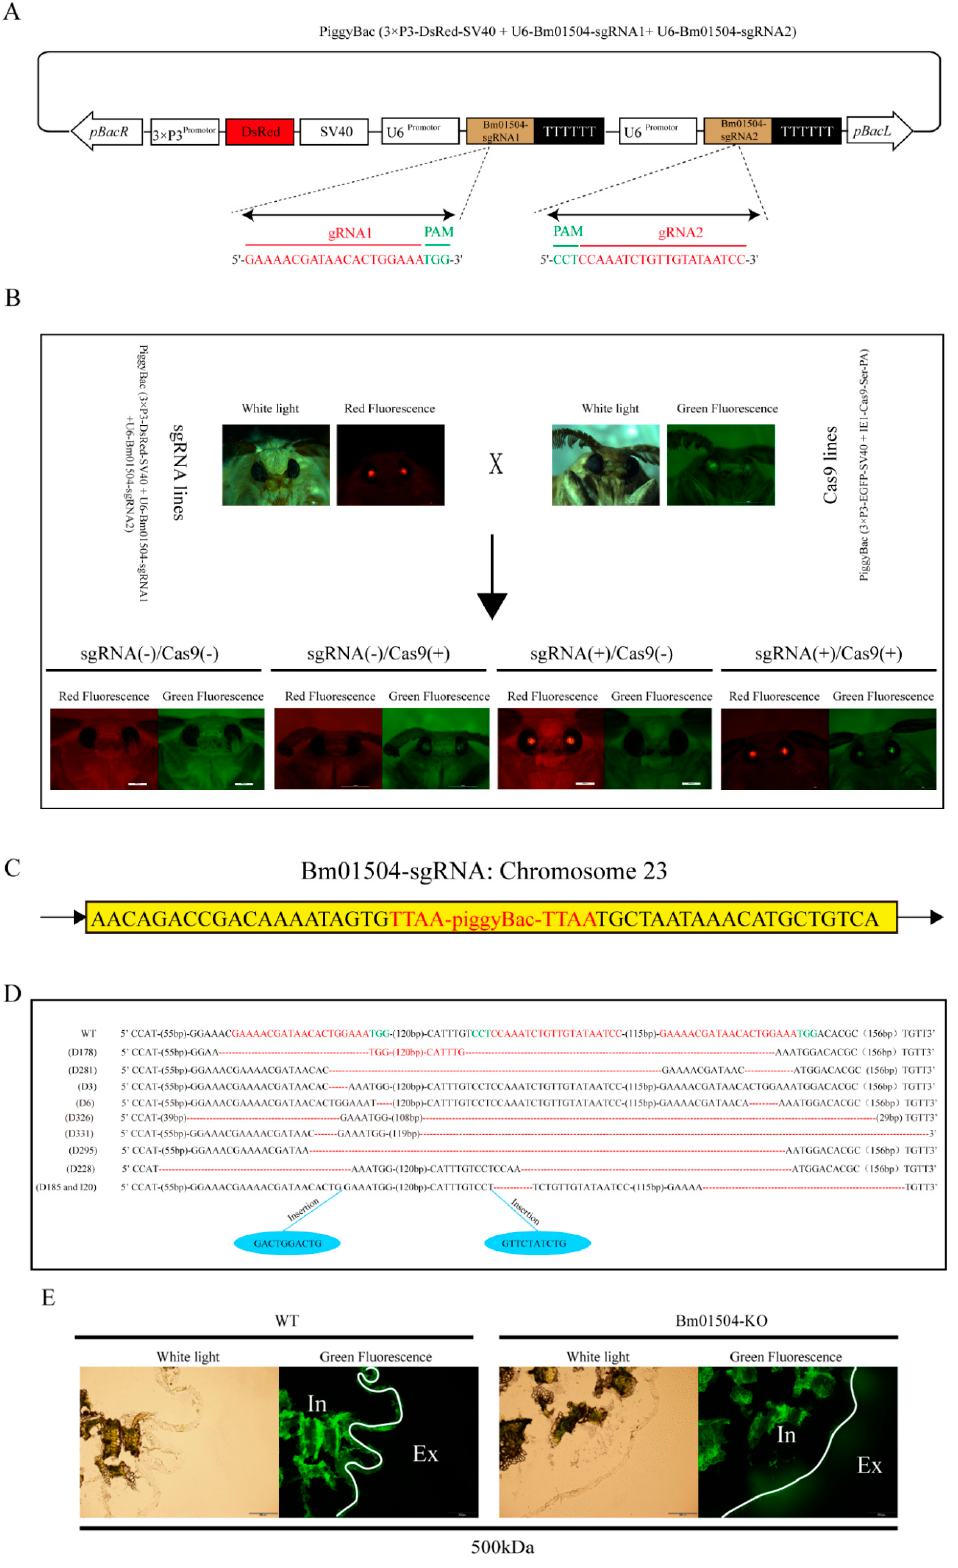
Figure5. GenerationofBm01504knockout(Bm01504-KO)transgenicsilkworms. ( A )Schematicdiagram of the piggyBac (3 × P3-DsRed-SV40 + U6-Bm01504-sgRNA1 + U6-Bm01504-sgRNA2) transgenic vector. DsRed was driven using 3 × P3 promoter and SV40 was used for termination signals of